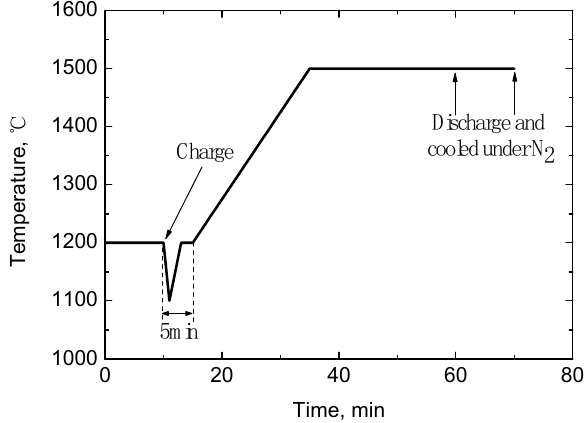
Figure 4. Schematic diagram of the temperature profile control of the electric muffle furnace.